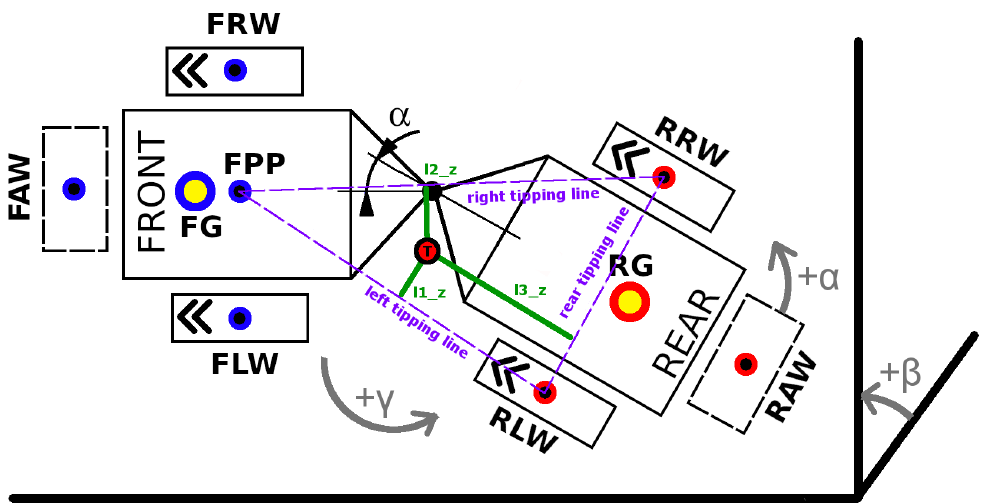
Figure 3. Position of skidder with front axle oscillation on slope: α —articulation of frame [ ◦ ], β —slope angle [ ◦ ], γ —rotation (=position) of skidder on slope [ ◦ ], l 1_ z , l 2_ z , l 3_ z —sides of stability triangle (left, right, and rear one). RLW, RRW—coordinates of contact points of rear tires with slope/terrain, T—center of gravity of skidder. Three green lines show distances of gravity vector (through T, center of gravity) to sides of stability triangle (=tipping lines) in 3D